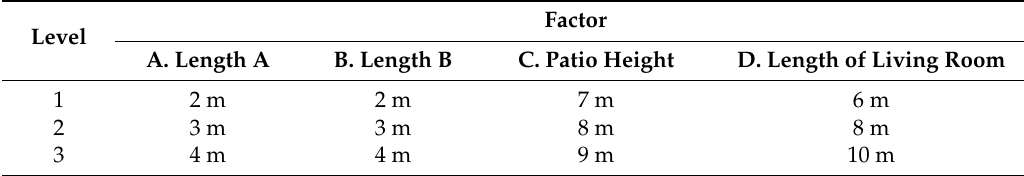
Table 2. Orthogonal factor standard table.